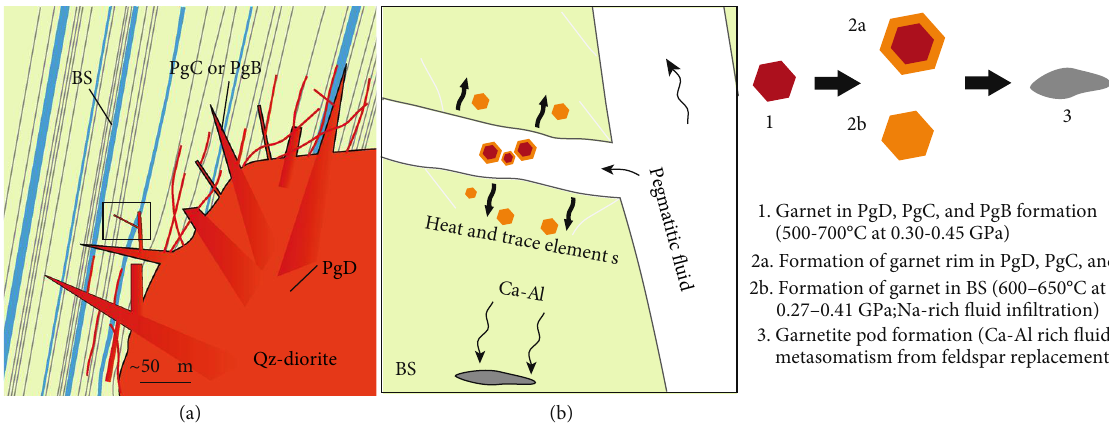
Figure 9: Schematic model of fl uid in fi ltration during pegmatite formation in the quartz diorite pluton and the surrounding metamorphic rocks. The fl uid in fi ltration and trace element in fl ux are recorded by the garnet texture and chemistry. The in fi ltration of Na-rich fl uid resulted in the formation of Ca-rich rims and sector zoning in garnets in the pegmatites, and heavy-REE-rich garnets in the biotite schist, which was then followed by in fi ltration of K-rich fl uids. Both fl uids resulted in Ca – Al metasomatism. PgD: Qz diorite-hosted pegmatite; PgC: Cpx schist-hosted pegmatite; PgB: Bt schist-hosted pegmatite; BS: Bt schist; QS: Qz schist; POD: garnetite